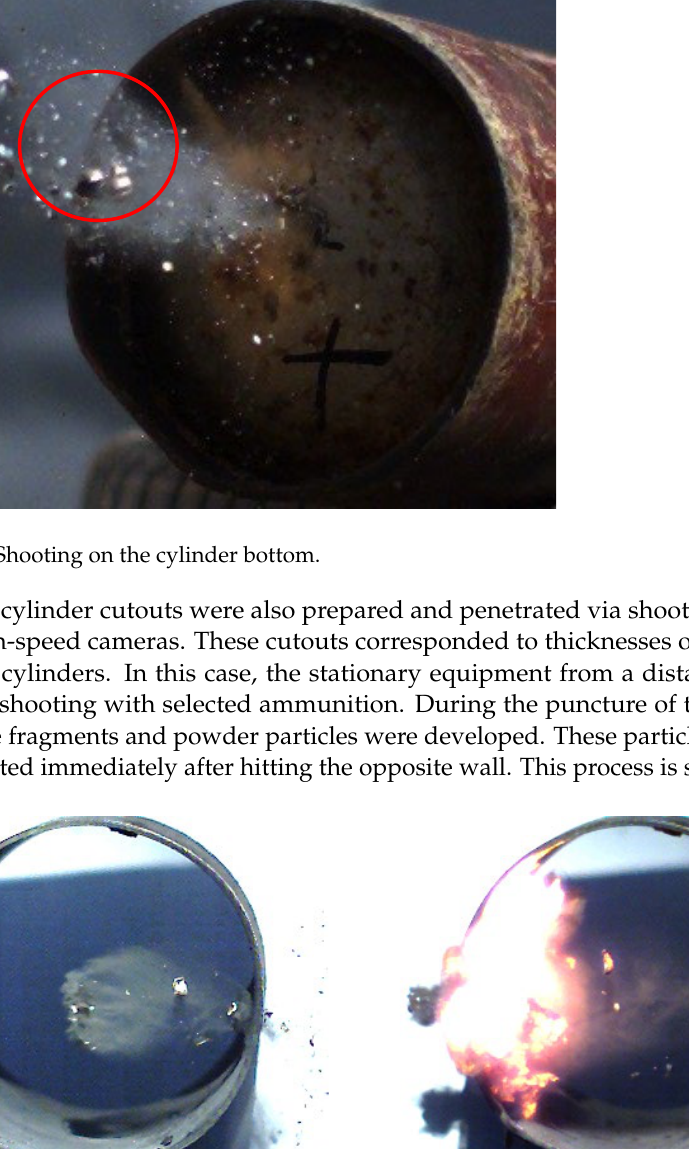
( d ) Figure 4. Temperature distribution on the unrolled cylinder shell: ( a ) 5 min; ( b ) 10 min; ( c ) 15 min; ( d ) 20 min. 3.2. Ammunition Selection Based on the cooperation with special forces, six types of ammunition were selected for penetrating the shell of acetylene cylinders. The aims of these tests were detailed recording of the ammunition’s impact and selecting suitable ammunition. If ammunition